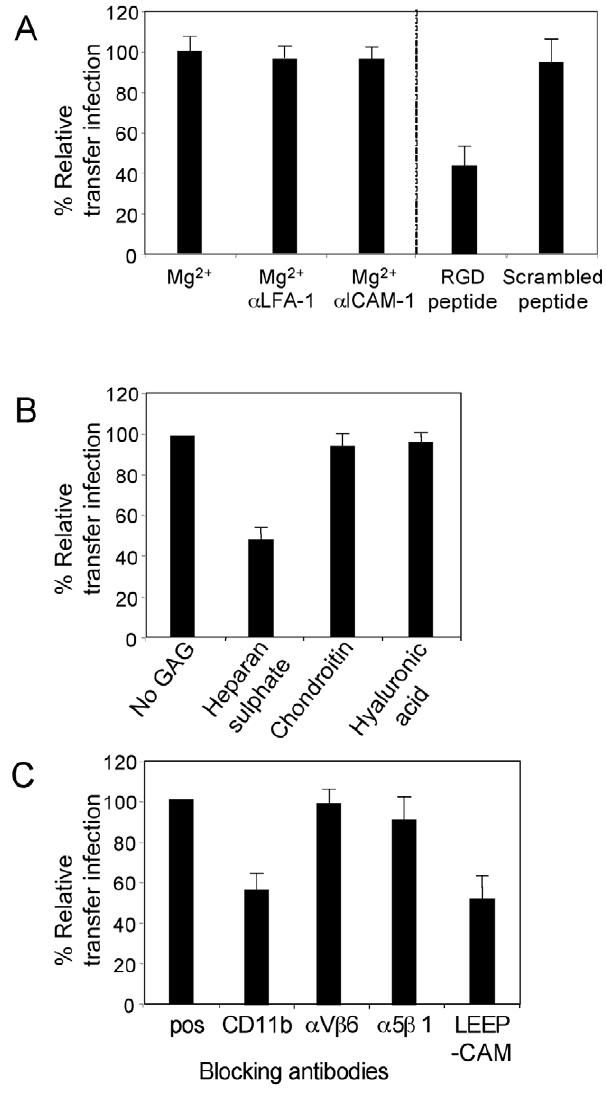
Figure 6. B cell adhesion to the epithelial cell basolateral surface. Primary tonsillar epithelial cells were plated onto 8 m M pore- size Transwells and grown until confluent. The polarized epithelial cells were examined by transfer infection via the basolateral surface for cation, RGD or GAG usage. (A) EBV-infected B cells (24 h p.i.) and epithelial cells were washed in Ca 2 + /Mg 2 + -free PBS. As above, co-culture was performed in binding buffer in the absence of cations (EDTA) or the presence of Mg 2 + , then under optimal cation conditions, B cells and epithelial cells were pre-incubated in blocking antibodies to LFA-1, ICAM-1, RGD peptide or scrambled peptide.Co-culture was performed for1 hour, then B cells washed off. The epithelial cells were trypsinised off the transwell membrane and plated onto 24 well plates. Infection was monitored by flow cytometry of . 10,000 cells for GFP after 24 hours and plotted as % infection (mean of triplicates) relative to the optimal cation conditions. (B) Under optimal conditions, the EBV-infected B cells (24 h p.i.) were pre- incubated with the GAGs: heparan sulphate, chondroitin sulphate and hyaluronic acid. Transfer infection was performed and analysed as in 6A and plotted as % infection (mean of triplicates) relative to the no GAG control. (C) EBV-infected B cells (24 h p.i.) were pre-incubated with (10– 20 m g/ml) blocking antibodies to CD11b, a V b 6 and b 1 integrins and LEEP-CAM before co-culture for 1 hour with polarized epithelial cells. The B cells were washed off and epithelial cells re-plated, as above. Epithelial infection was monitored by GFP expression after 24 hours by flow cytometry of . 10,000 cells and plotted as % infection (mean of triplicates) relative to the positive control.